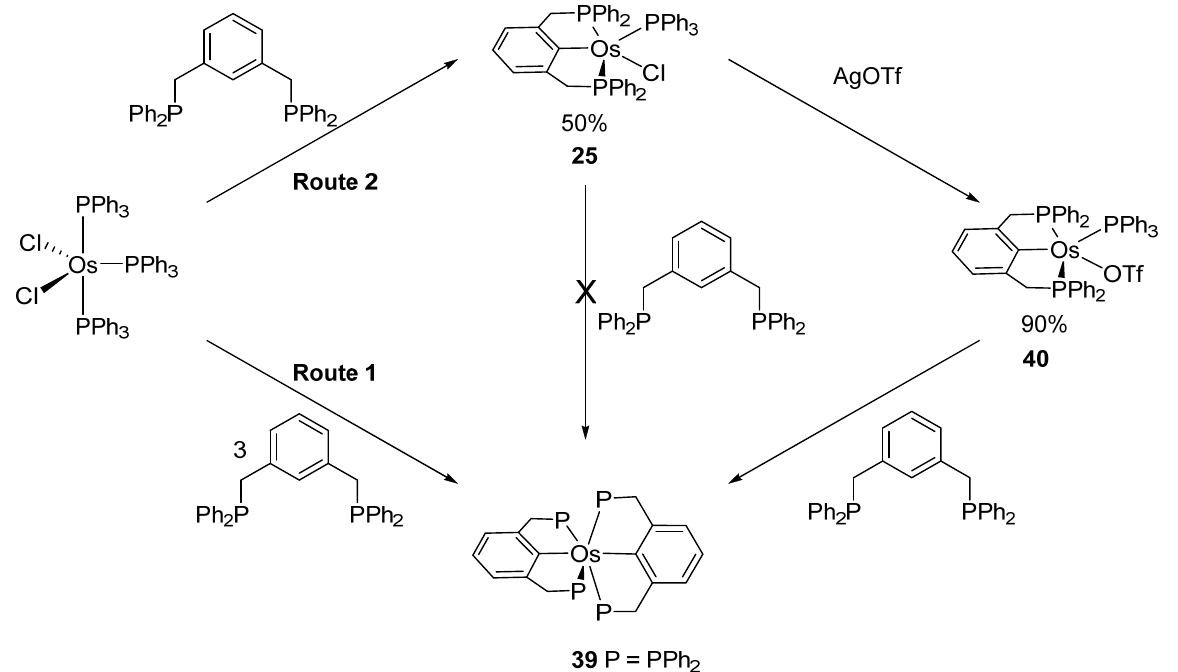
Figure 10. Synthesis of bis -(P~C~P) pincer complexes from 1,3-bis(diphenyl-phosphinomethyl)benzene.